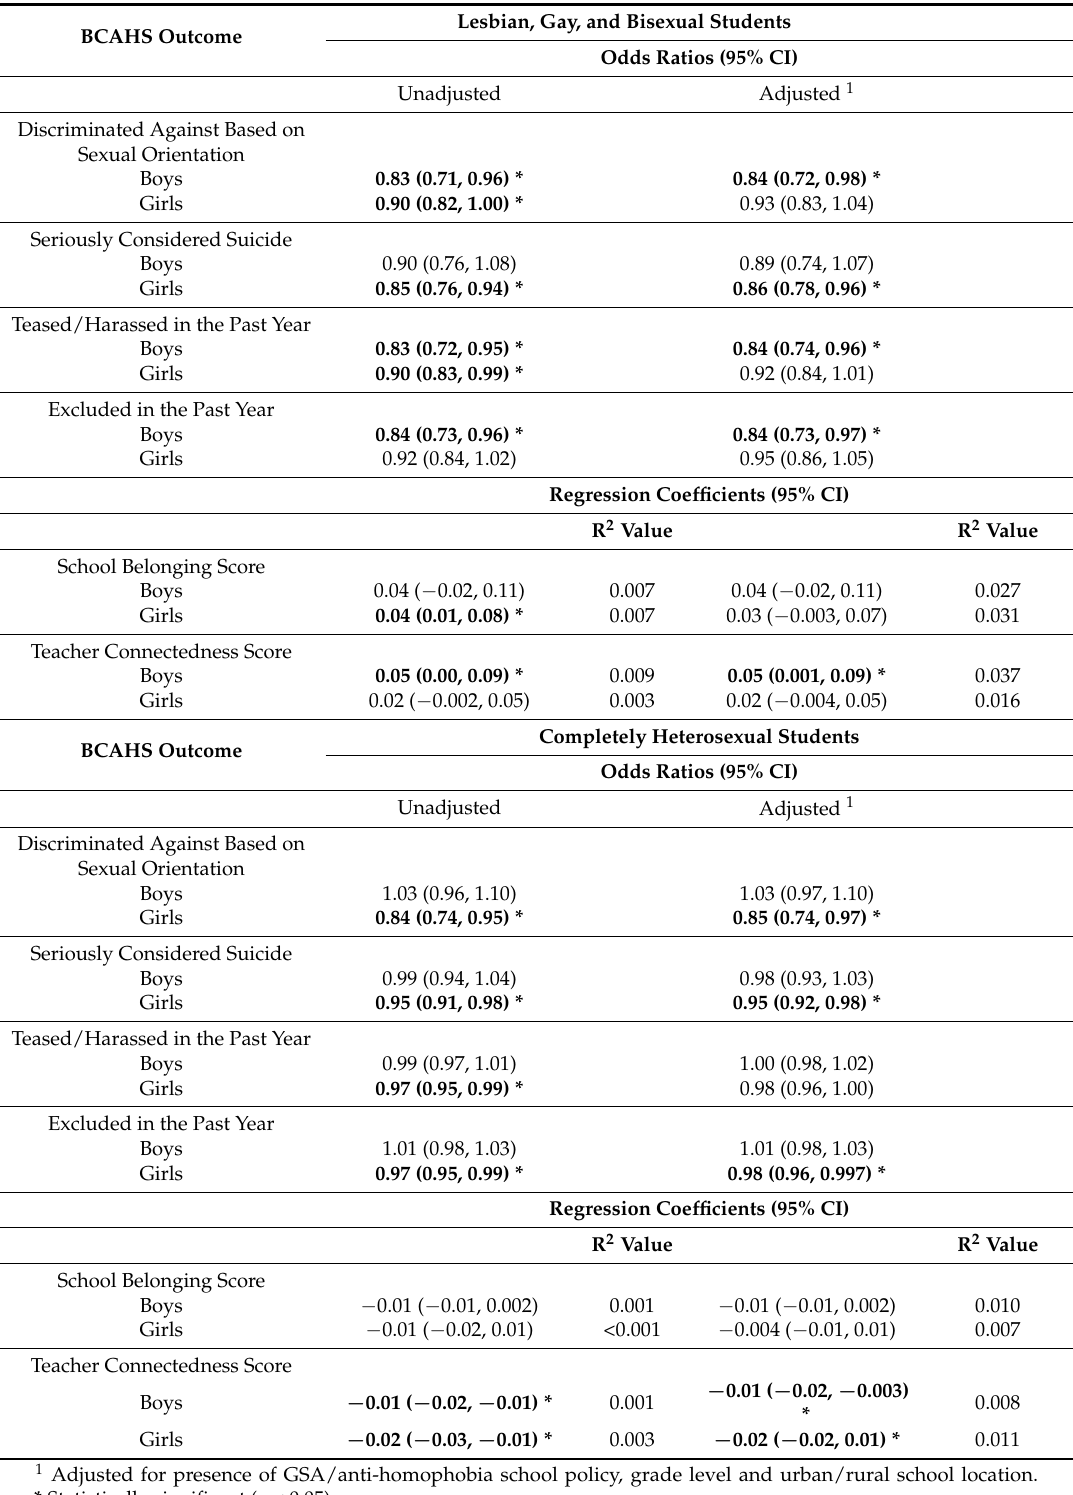
Table 4. Relationship between health outcome measures among lesbian, gay, bisexual and heterosexual students and number of Out in Schools events hosted per school since 2004. Lesbian, Gay, and Bisexual Students BCAHS Outcome Odds Ratios (95% CI) Unadjusted Adjusted